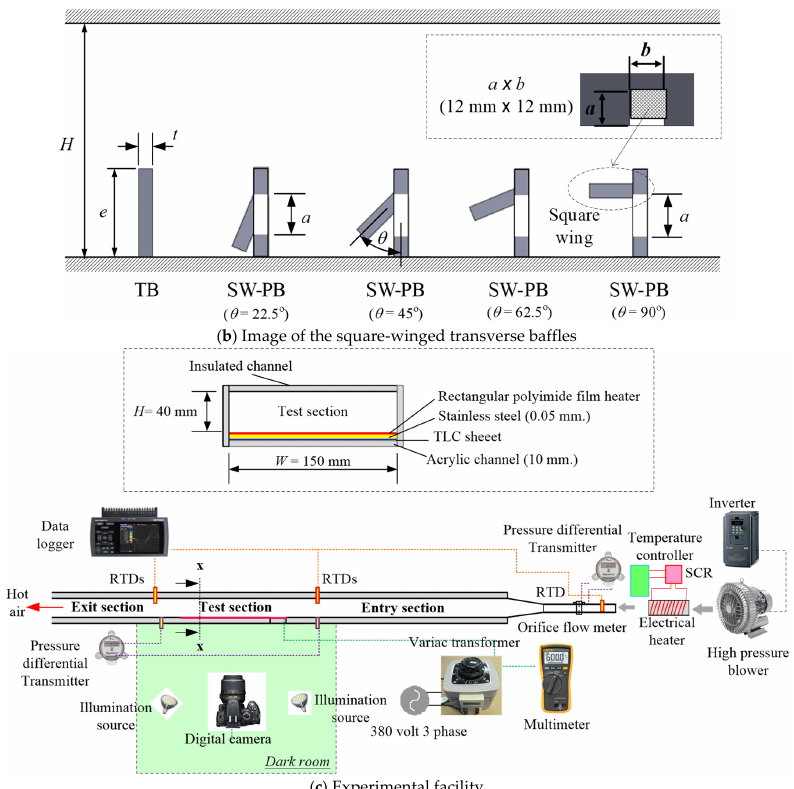
Figure 2. ( a ) Design of the channel and square-wing transvers baffles; ( b ) the structures of the channels into which the square-winged transverse baffles were installed, with various wing attack angles ( θ ); and ( c ) the experimental setup.